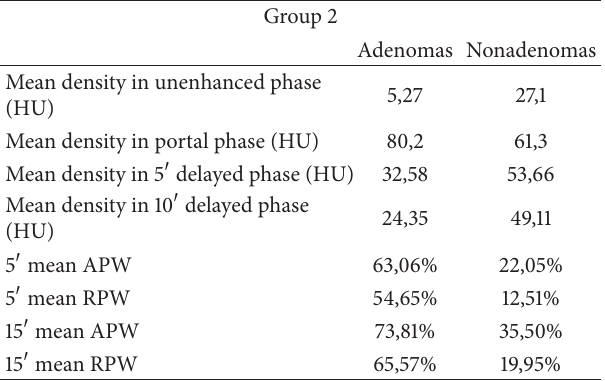
Table 2: Mean densitometric values obtained in group 2. Group 2 Adenomas